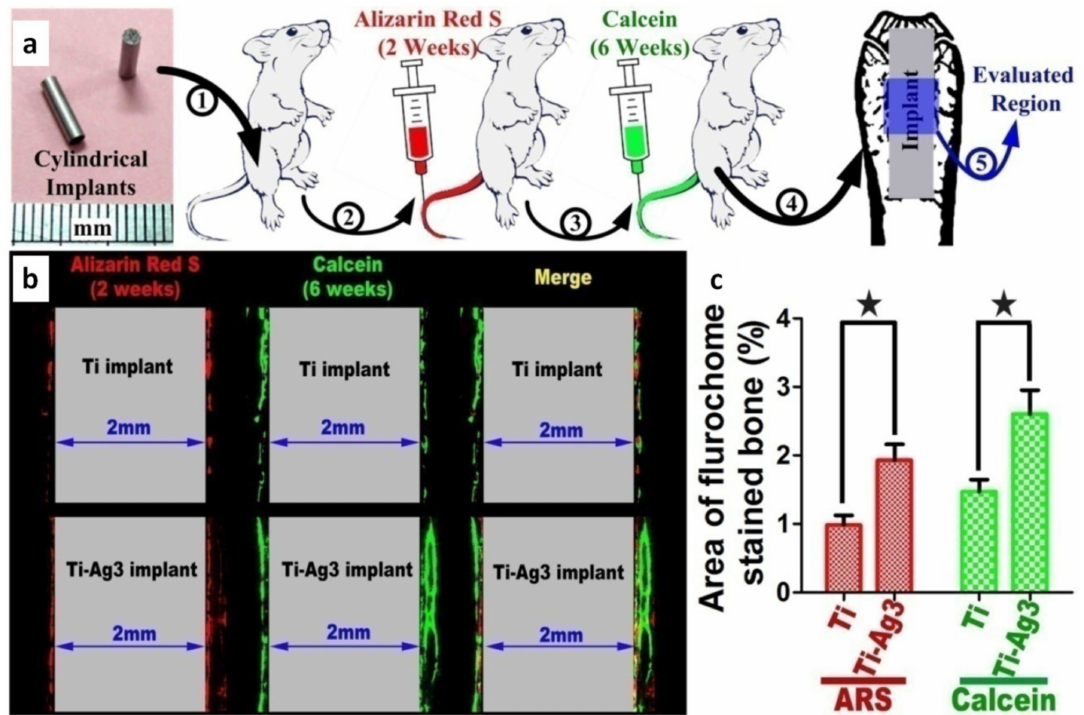
Figure 7. Immobilized AgNPs accelerated the osteointegration properties of titanium: ( a ) schematic of the surgical procedure, ( b ) sequential fluorescent labelling of the implant-bone boundaries of Ti and the Ti − Ag3 group, ( c ) percentage of new bone stained with Alizarin Red S (ARS) and calcein in (b); (cid:70) represents p < 0.05. Reproduced from [78], with permission American Chemical Society